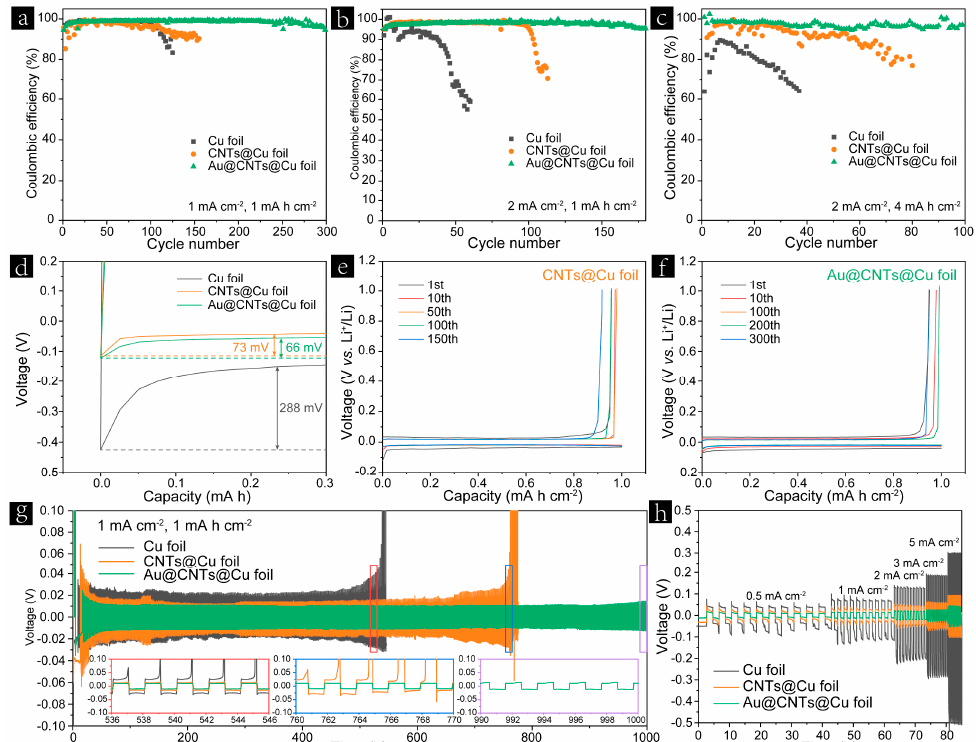
Figure 3. Coulombic efficiencies of Cu foil, CNTs@Cu foil, and Au@CNTs@Cu foil electrodes at ( a ) 1 mA cm − 2 with 1 mA h cm − 2 , ( b ) 2 mA cm − 2 with 1 mA h cm − 2 , and ( c ) 2 mA cm − 2 with 4 mA h cm − 2 . ( d ) Voltage profiles of initial Li nucleation on Cu foil, CNTs@Cu foil, and Au@CNTs@Cu foil at a current density of 1 mA cm − 2 . Voltage profiles of ( e ) CNT@Cu foil and ( f ) Au@CNT@Cu foil under different cycles at a current density of 1 mA cm − 2 with an areal capacity of 1 mA h cm − 2 . Galvanostatic cycling stabilities of the predeposited Cu foil-Li, CNTs@Cu foil-Li, and Au@CNTs@Cu foil-Li electrodes at ( g ) 1 mA cm − 2 and ( h ) different current densities with an areal capacity of 1 mA h cm − 2 .